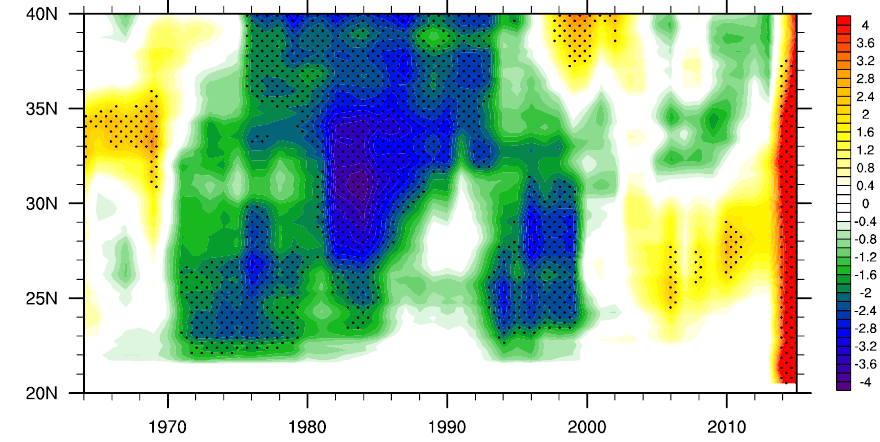
Figure 1. The time–latitude cross–section of the 7–year running mean of frequency of extreme high–temperature events (FEHE) anomalies (unit: 1) during summer relative to the climatic summer mean for 1961–2018 averaged over 105° E–120° E. The dots denote where the anomalies exceed one standard deviation.